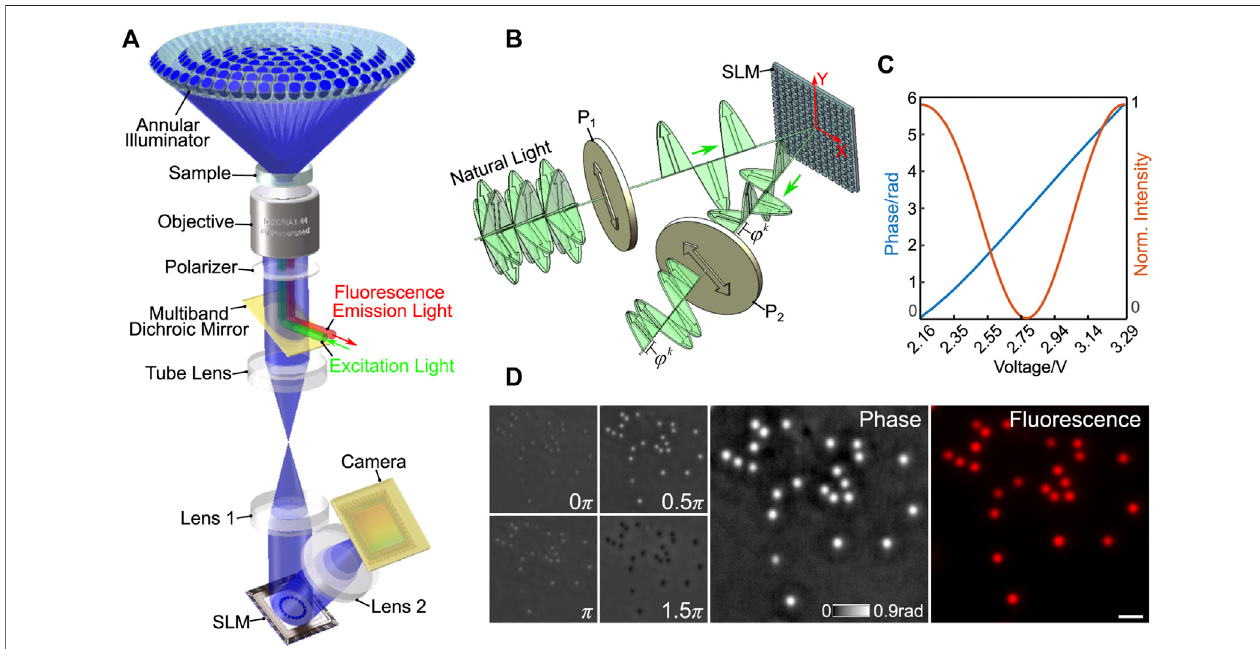
FIGURE1|(A) TheschematicdiagramofCF-QPCM. (B) Theschematic setupfor SLM calibration. (C) Calibrationcurves: themeasured intensity(orange) and the modulatedphase(blue)versustheloadedvoltage. (D) Phaseand fl uorescenceimagesof fl uorescentpolystyrenespheres(diameter:300 nm).Theleftistherawintensity images obtained during the four-step phase-shifting operation, and the right is the reconstructed phase image and the fl uorescence image. Scale bar in (D) represents 1 μ m.